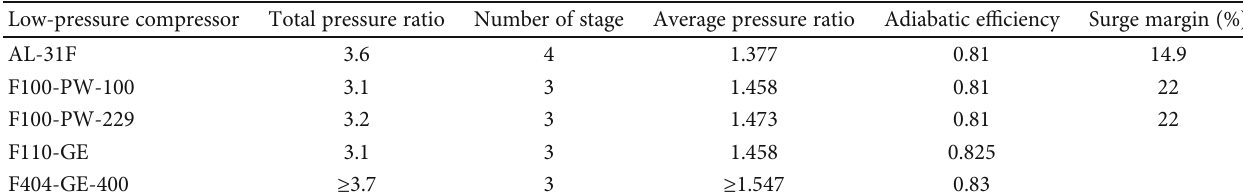
Table 2: Performance comparison between the AL-31F low-pressure compressor and advanced international low-pressure compressors.